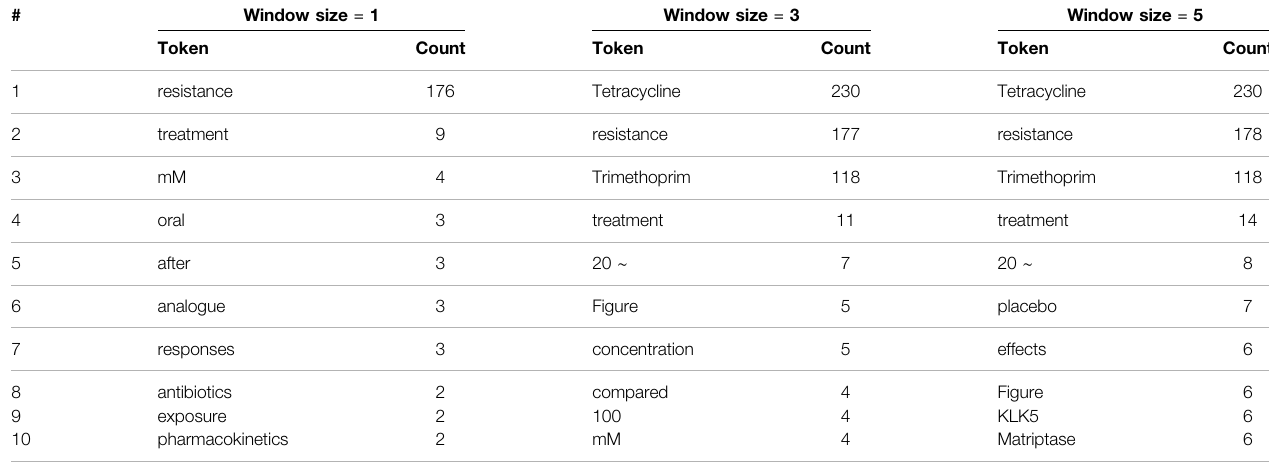
TABLE 4 | The 10 most frequent tokens, excluding stop words and punctuation marks, within various window sizes around entities correctly labeled by human reviewers.